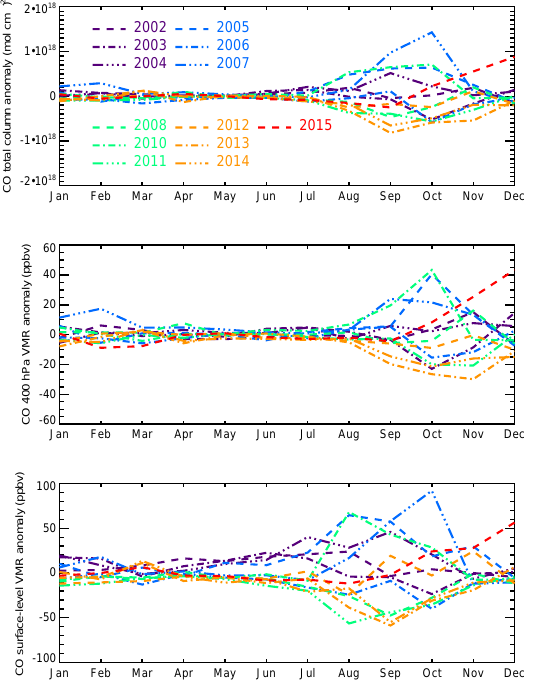
Figure 10. Monthly-mean anomalies of MOPITT TIR-NIR CO products for each of the years used to generate the long-term monthly means shown in Fig.